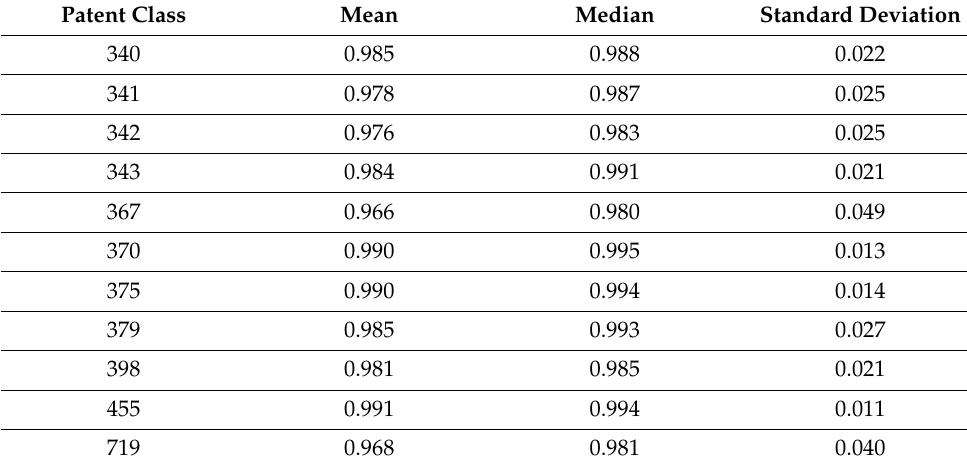
Table 2. Personal best—summary statistics of α